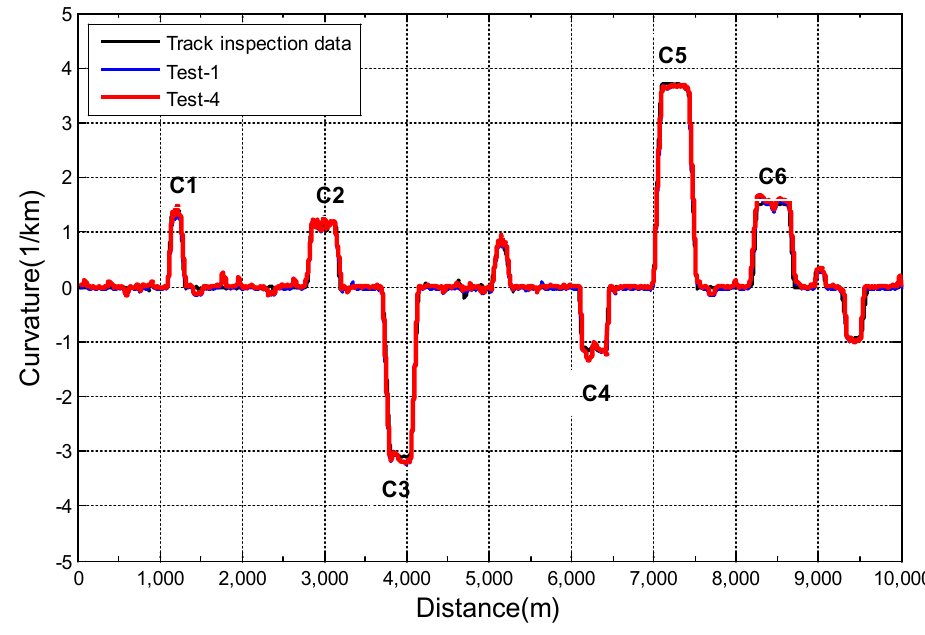
Figure 15. Curvature test result.